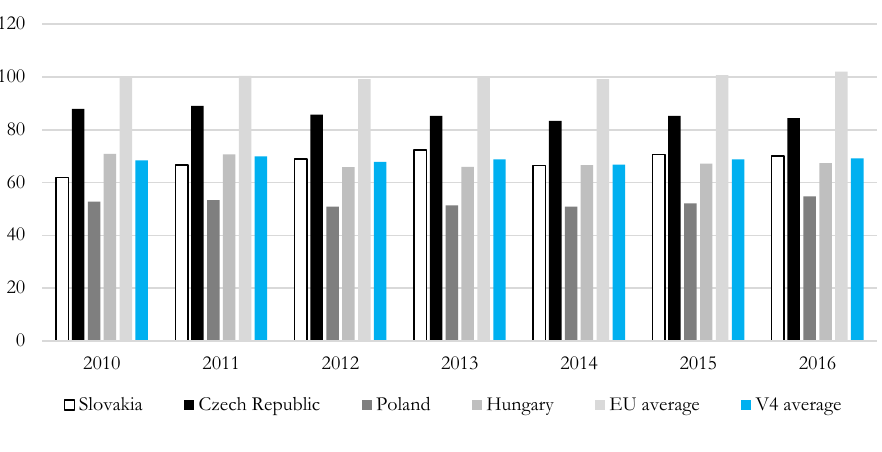
Fig. 1 – Summary Innovation Index 2010 – 2016. Source: own processing according to the European Innovation